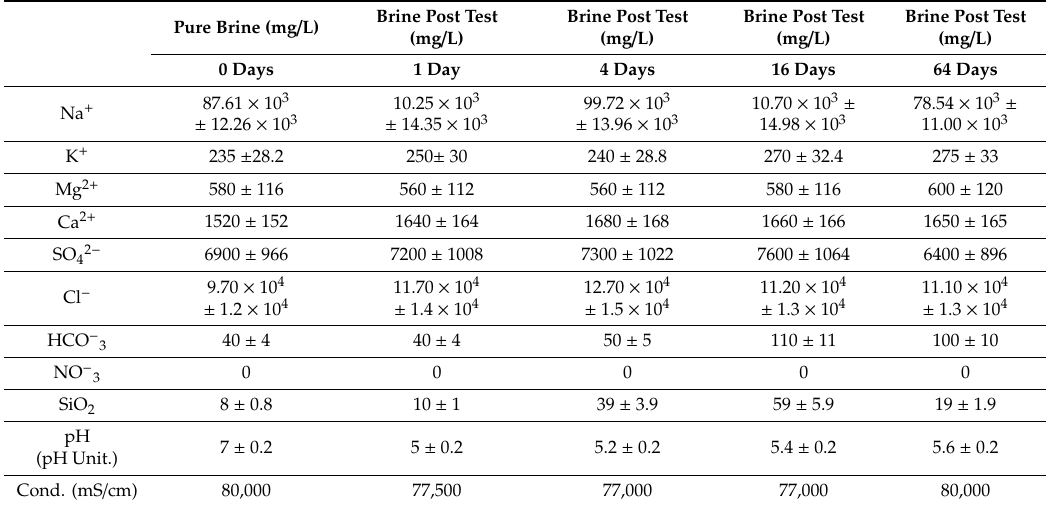
Table 7. Chemical analysis of pure brine and brine taken from the reaction chambers (1, 4, 16 and 64 days) with GD (Figure S2 as supplementary